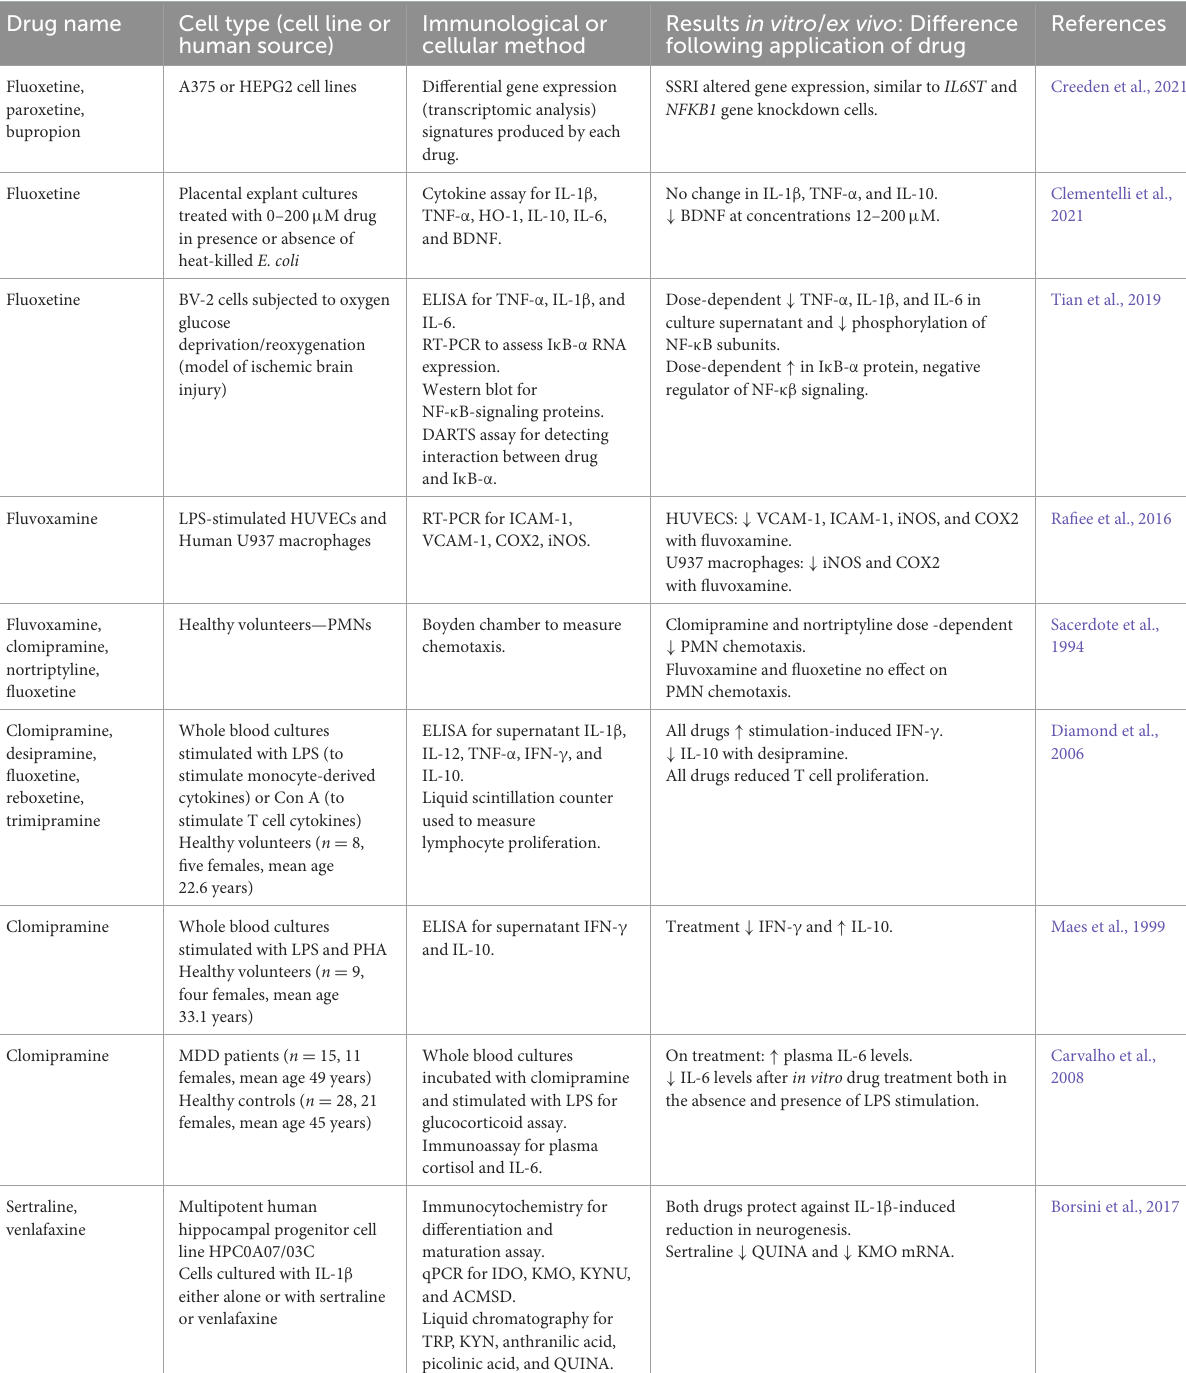
TABLE 2 Anti-inflammatory effects of SSRIs and/or SNRIs using in vitro or ex vivo human cells in culture or stimulation